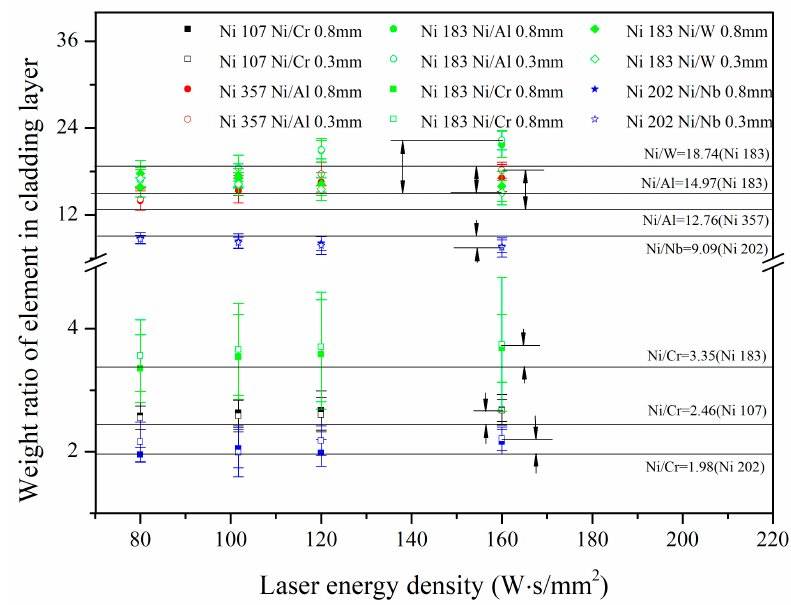
Figure 5. Weight ratio among di ff erent element in laser cladding layers. In this picture, the color represents the number of Ni-based alloy powders: Black-Ni 107, green-Ni 183, blue-Ni 202 and red-Ni 357. The shape of the point means weight ratio between di ff erent element: Square-Ni / Cr, circle-Ni / Al, rhombus-Ni / W and star-Ni / Nb. The empty point represents the thickness of the pre-placed powder layer (0.3) mm, and the solid point represents the thickness (0.8 mm); the parallel lines mean the weight ratios of elements in the original powders.